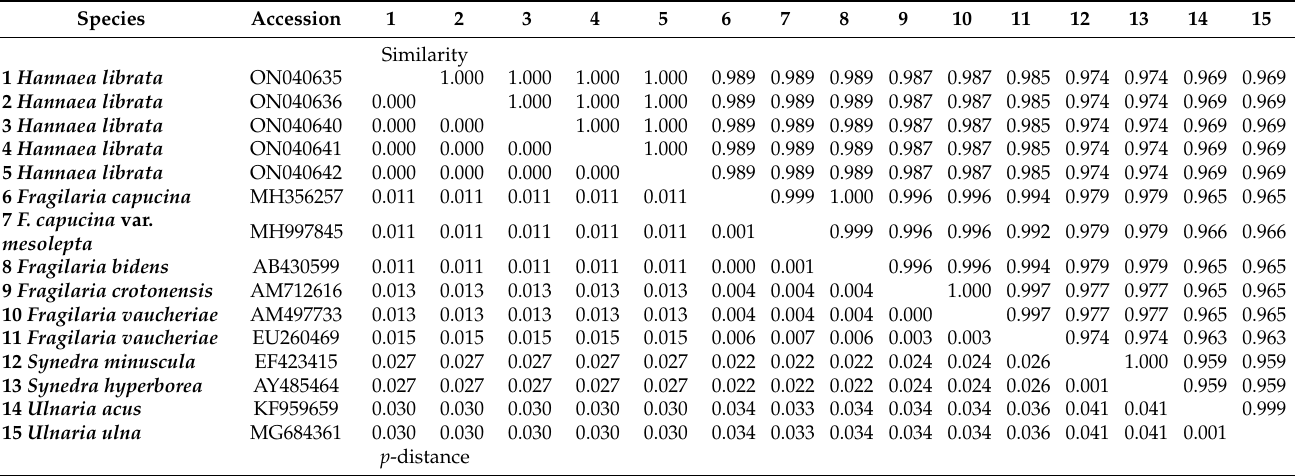
Table 3. Similarity scores and genetic distances among 15 aligned sequences (1478 bp) based on SSU rRNA